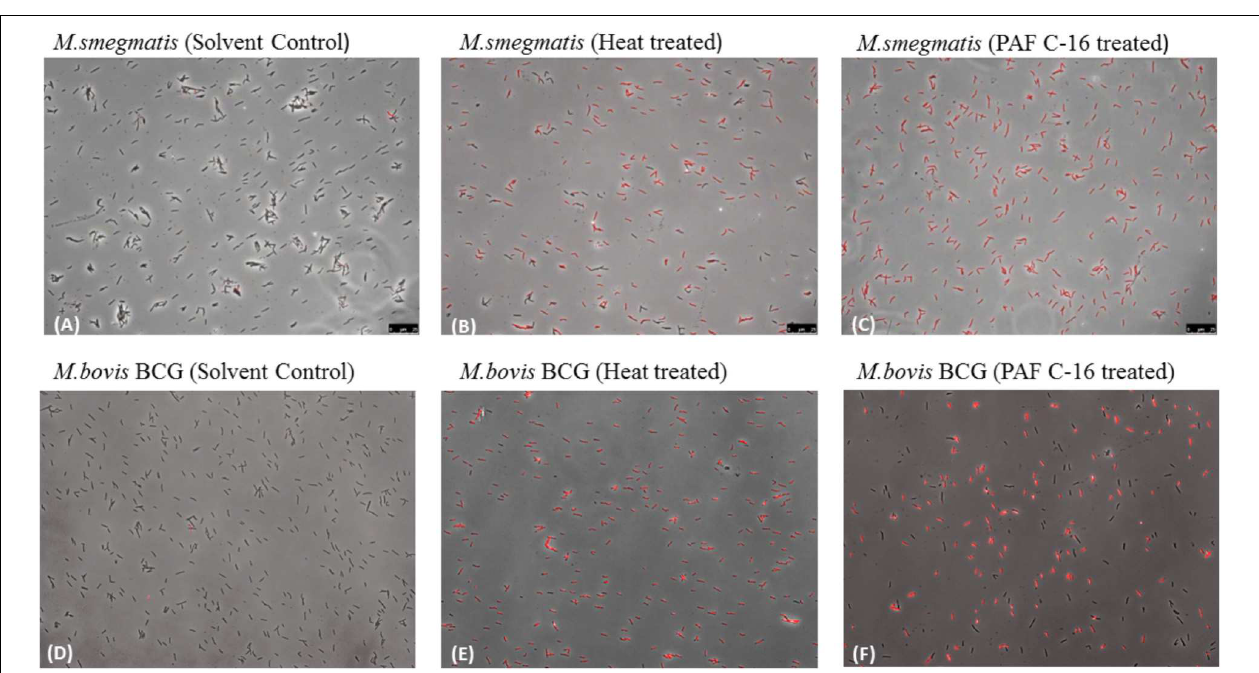
FIGURE 7 | Fluorescence microscopy to detect the effect of PAF C-16 treatment on M. smegmatis and M. bovis BCG cell membrane integrity. M. smegmatis (A–C) and M. bovis BCG (D–F) treated with PAF C-16 (100 µ g/ml) or solvent control (10 µ l/ml ethanol) for 2 h and heat killed (100 ◦ C, 10 min) as a positive control were stained with the nucleic acid binding dye propidium iodide and imaged at 400 × magnification in bright field and CY3 (PI) channels. Panels show a merger of the two channels. (A,D) are solvent treated negative control, (B,E) are heat treated positive control, (C,F) are PAF C-16 treated